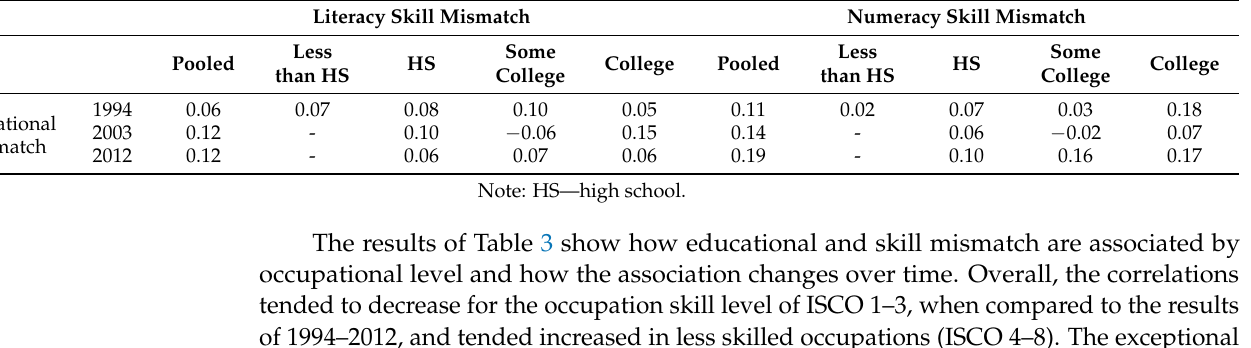
Table 2 delineates correlations between educational and skill mismatch by educational